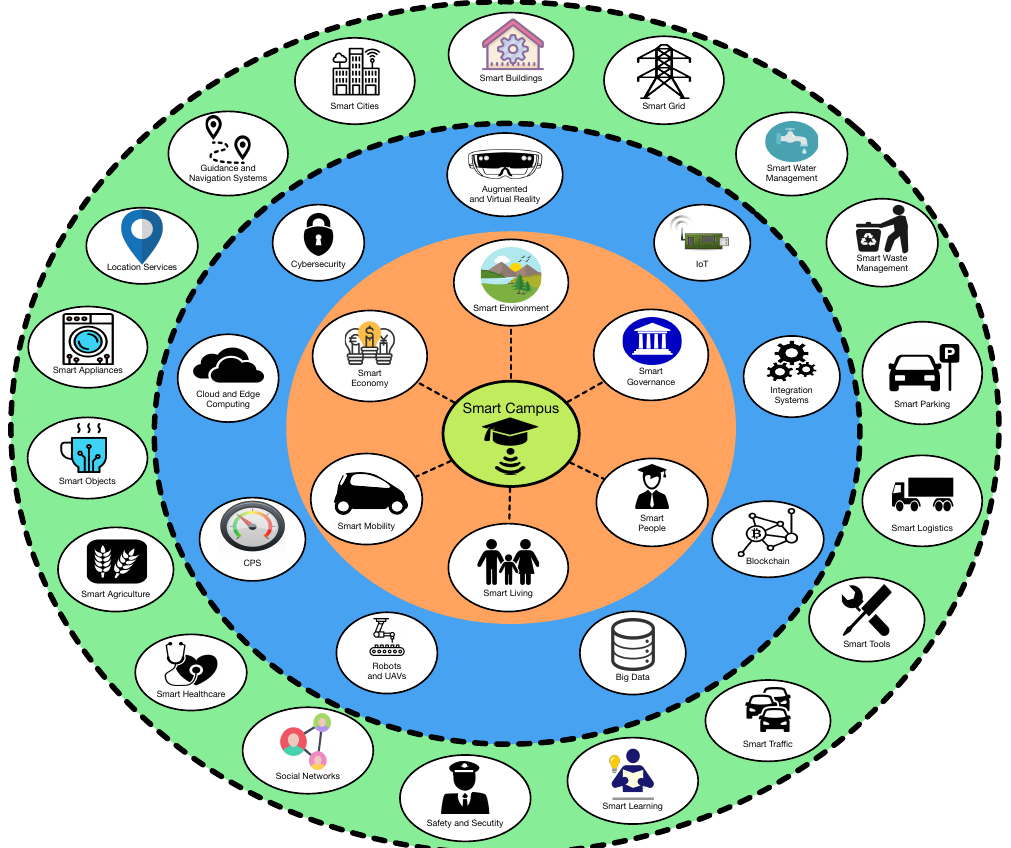
Figure 1. Main fields and technologies of a smart